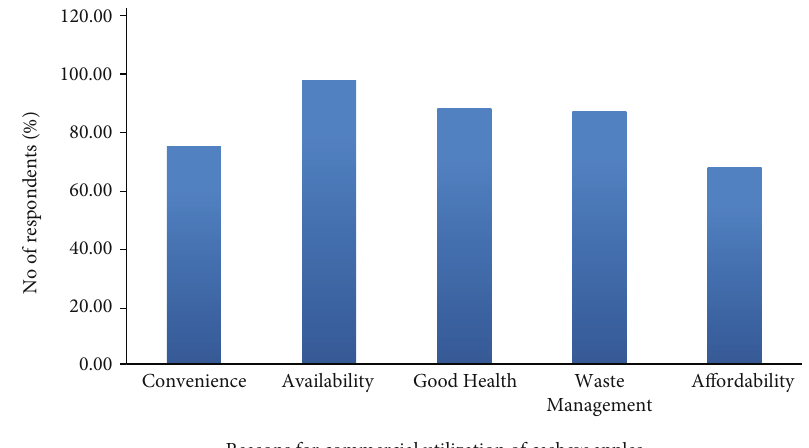
Figure 4: Possible reasons for commercialization of cashew apple value-added products.